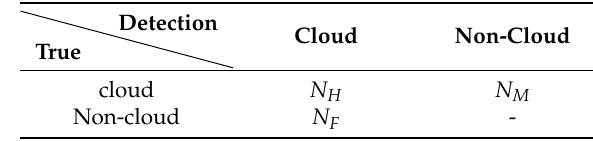
Table 2. The meanings of